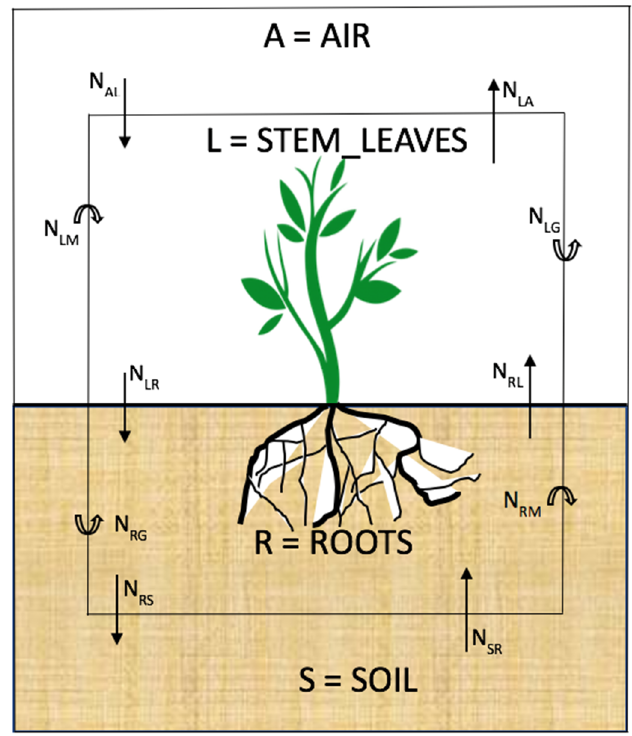
Figure 1. The plant Model.